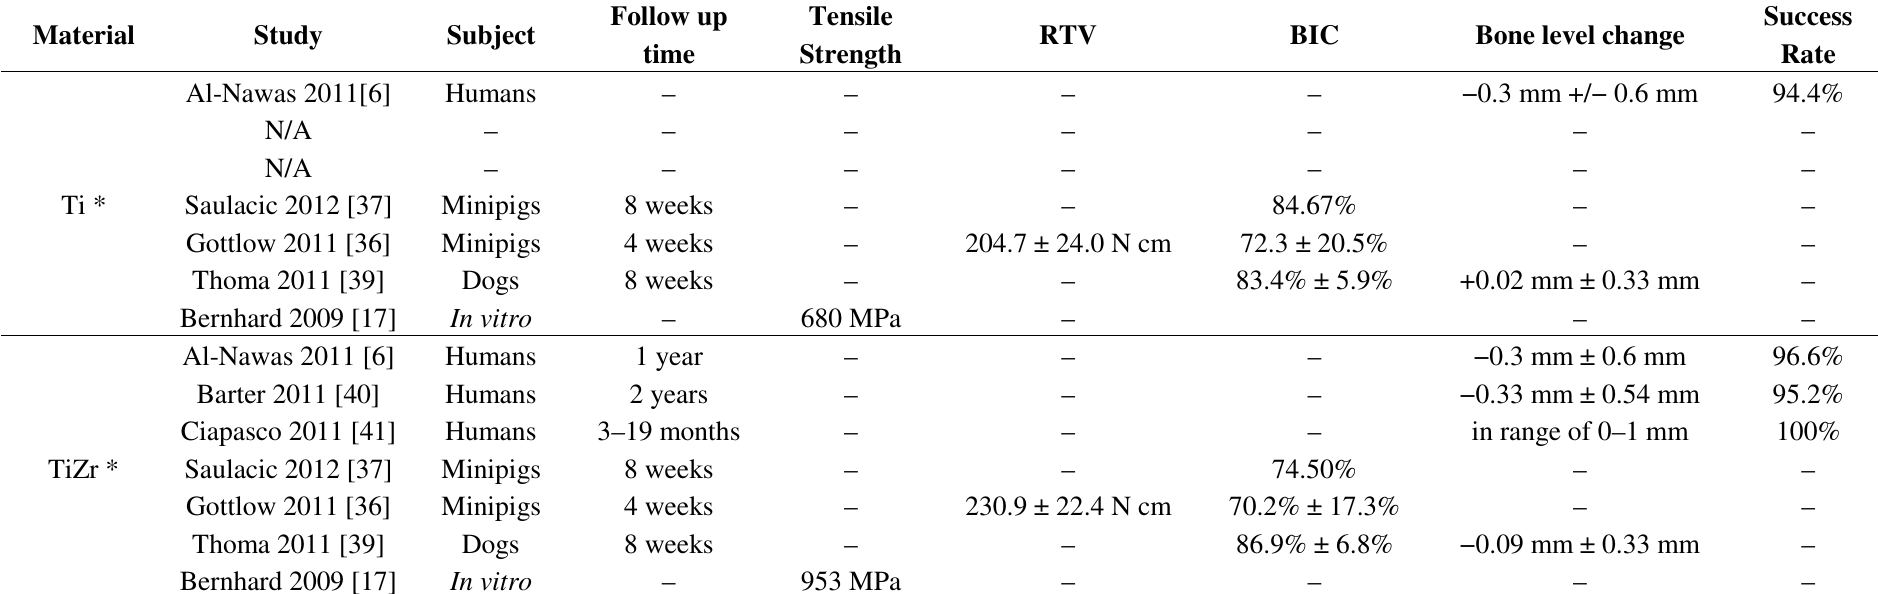
Table 4. Comparison of TiZr vs. Ti tensile strength, removal torque values (RTV), bone-to-implant contact (BIC), bone level change, and implant success